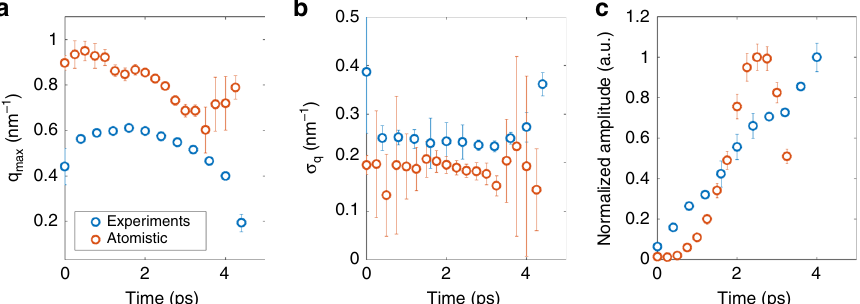
Fig. 6 Imprinted demagnetisation and dissociation for non-AOS. Fitted parameters of the Gaussian feature from experiments (blue circles) and atomistic simulations (red circles): a ring radius, b ring width, and c normalised amplitude. The appearance of a pattern seeded by the material ’ s chemical inhomogeneity is evidenced by the relatively constant ring radius and ring width after optical pumping accompanied by a growth in the normalised amplitude. At longer times, the magnetic texture dissociates from the chemical inhomogeneities evidenced by the sudden drop of the experimental ring radius and a drop in the atomistic amplitude. Error bars represent standard